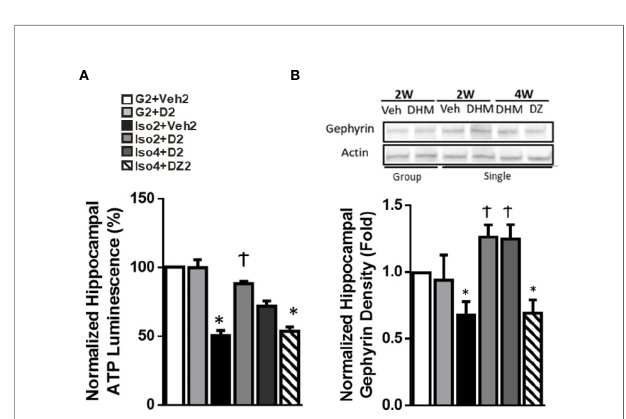
FIGURE 3 | DHM restores hippocampal ATP levels and gephyrin protein expression induced by social isolation in mice. (A) Effects of social isolation and DHM treatment on ATP levels in microdissected hippocampi (nM/mg of tissue). One-way ANOVA followed by multiple comparison, Sidak method; F (5,18) = 9.999, p<0.0001. n=4/group. (B) Representative Western blot of gephyrin expression in hippocampal sections from different treatment groups. Group: group housing for 2w; Single: singly housed for 2w or 4w, followed by Veh (vehicle), DHM or DZ treatment for 2w. The Western blot image